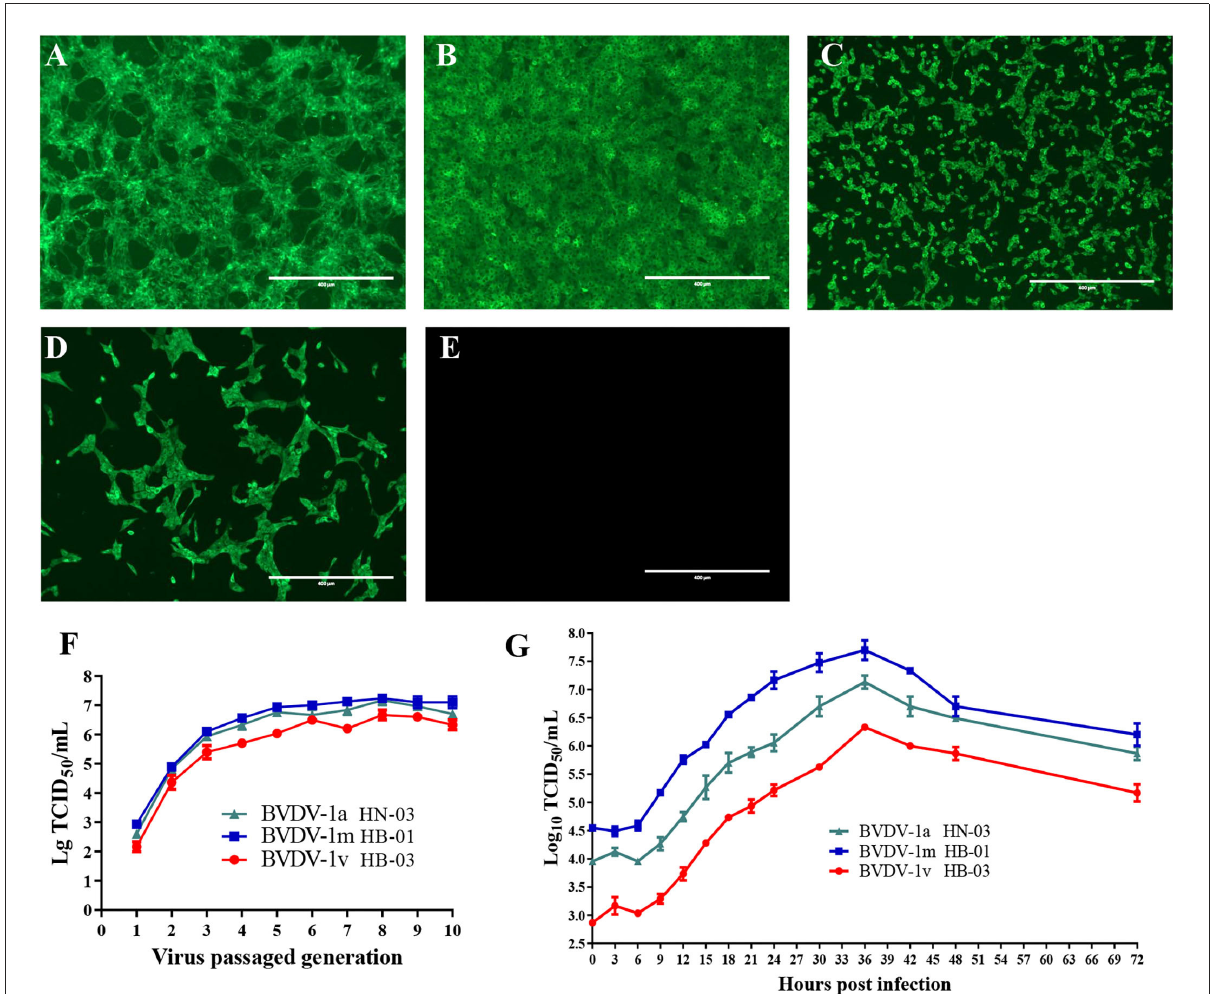
FIGURE2 Viral isolation and characterization. The specific immunofluorescent signals were detected in the cytoplasm of cells inoculated with BVDV-1a HN-03 (A) , BVDV-1m HB-01 (B) , and BVDV-1v HB-03 (C) . Madin-Darby bovine kidney (MDBK) cells inoculated with BVDV-1b AV-69 (as a positive control) cells showed specific fluorescence (D) , and mock-infected cells showed no bright fluorescence (E) . Median tissue culture infectious dose (TCID 50 ) of the three bovine viral diarrhea virus (BVDV) isolates inoculated with MDBK in passages (F) . One-step growth curves